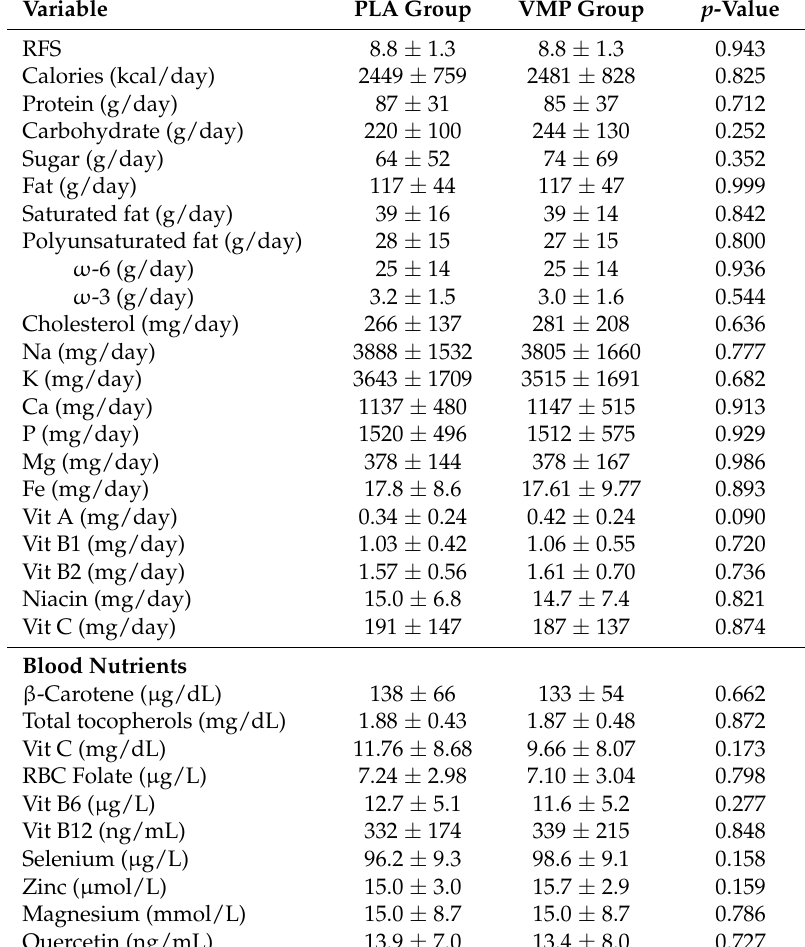
Table 4. Baseline dietary intake from food frequency questionnaire and blood nutrient